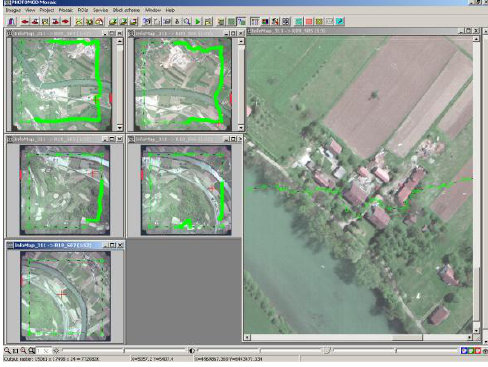
Figure 9. Tie points to eliminate residual discrepancies along cut